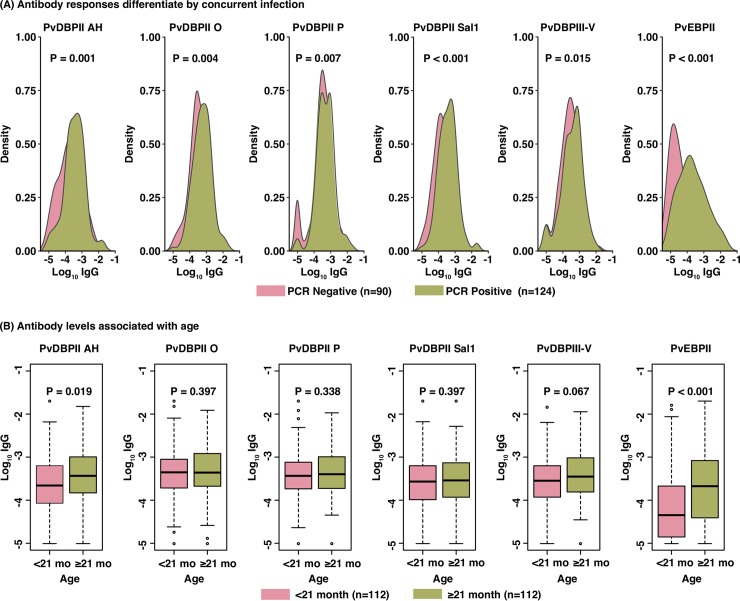
Distribution of antibody responses by the presence of malaria infection (A) and age (B). The X-axis represented log10 transformed antibody responses and the Y-axis represented the observed distribution of the antibody responses. Individuals without infection were shown in red and with infection in blue. Infection was determined by PCR at enrollment (A). Children were categorized into < 21 months of age (n = 112) and ≥ 21 months of age (n = 112) (B). P values were calculated using Wilcoxon-signed rank test. P<0.05 was considered significant.